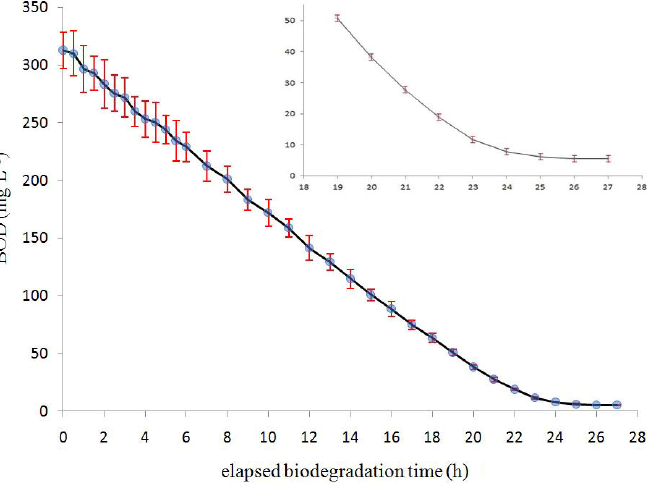
Figure 5. BOD (mg L − 1 ) in the ordinate vs. elapsed biodegradation time (h) in the abscissa. In the inset (top right), details of the last few h of the biodegradation experiment are shown. For the sake of clarity, error bars (which represent the standard deviation of five measurements) are exaggerated by a factor of